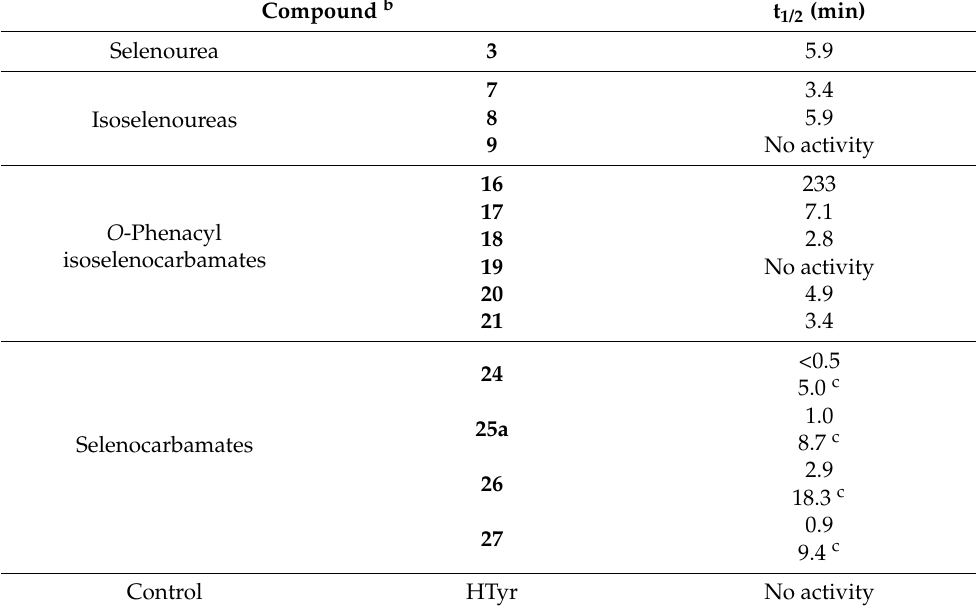
Table 2. Glutahione peroxidase mimicry of seleno-derivatives a . Compound